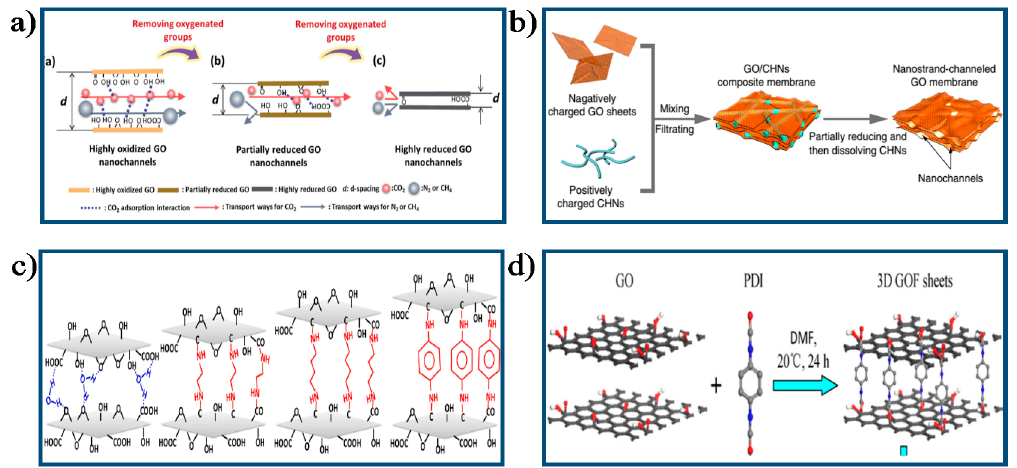
Figure 7. Schematic diagram of the process to tune the structure of GO membrane by chemical method: ( a ) Schematic illustration of the process to tune the microstructure of GO membranes via reduction method [24]. Copyright 2016 Royal Society of Chemistry; ( b ) The fabrication process of NSC–GO membrane [88]. Copyright 2013 Nature Publishing Group; ( c ) The fabrication process of GOF membranes cross-linked with diamine monomers [110]. Copyright 2014 American Chemistry Society; ( d ) The fabrication process of GOF membrane [27]. Copyright 2016 Elsevier.